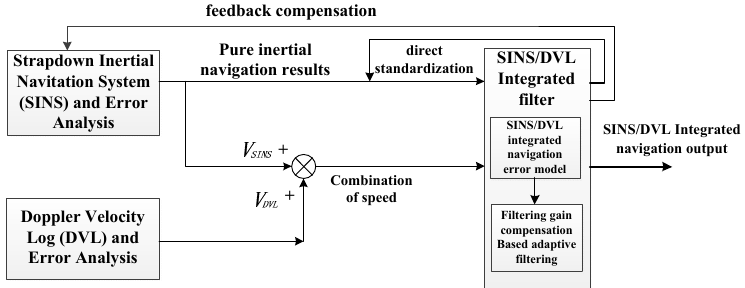
Figure 1. The framework for the strapdown inertial navigation system (SINS) / Doppler velocity log (DVL) integrated positioning system based on a filtering gain compensation adaptive Kalman filter.